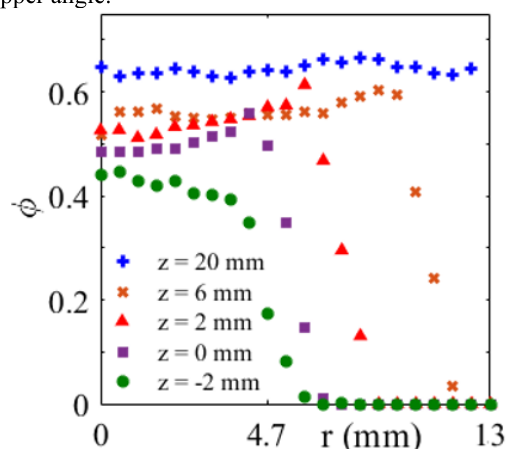
Fig. 4. The solid fraction profiles along the radius of the 30° hopper.